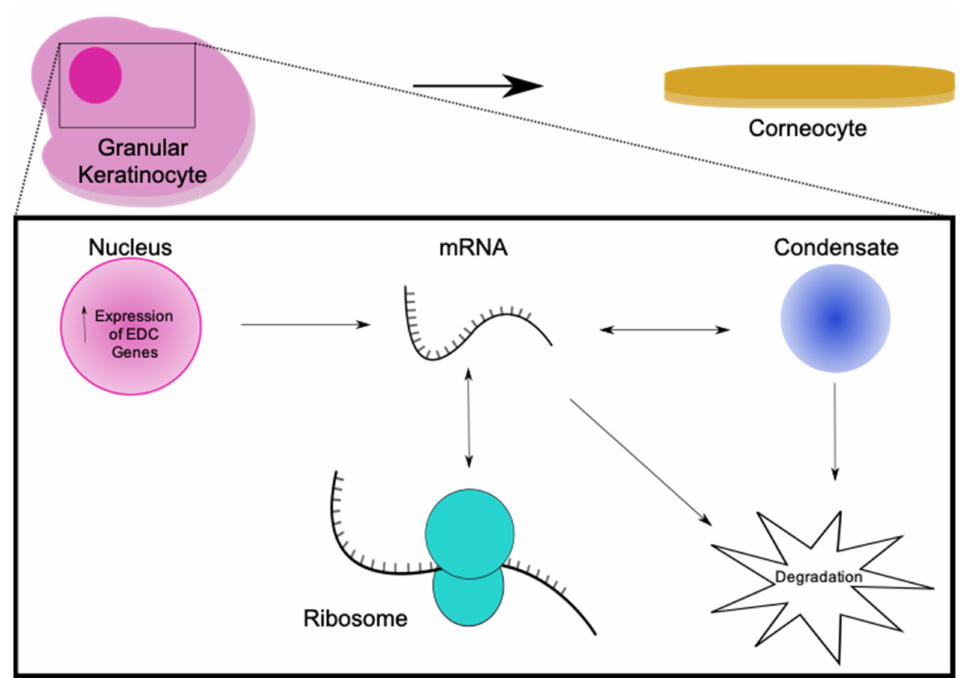
Figure 2. The potential role of condensates in keratinocyte terminal di ff erentiation. In a granular keratinocyte undergoing the last stages of terminal di ff erentiation, condensates may form from the excess RNA being produced by loci such as the EDC. These condensates may act as a sink for mRNA, either targeting it for degradation or allowing it to re-enter the translational pool from the